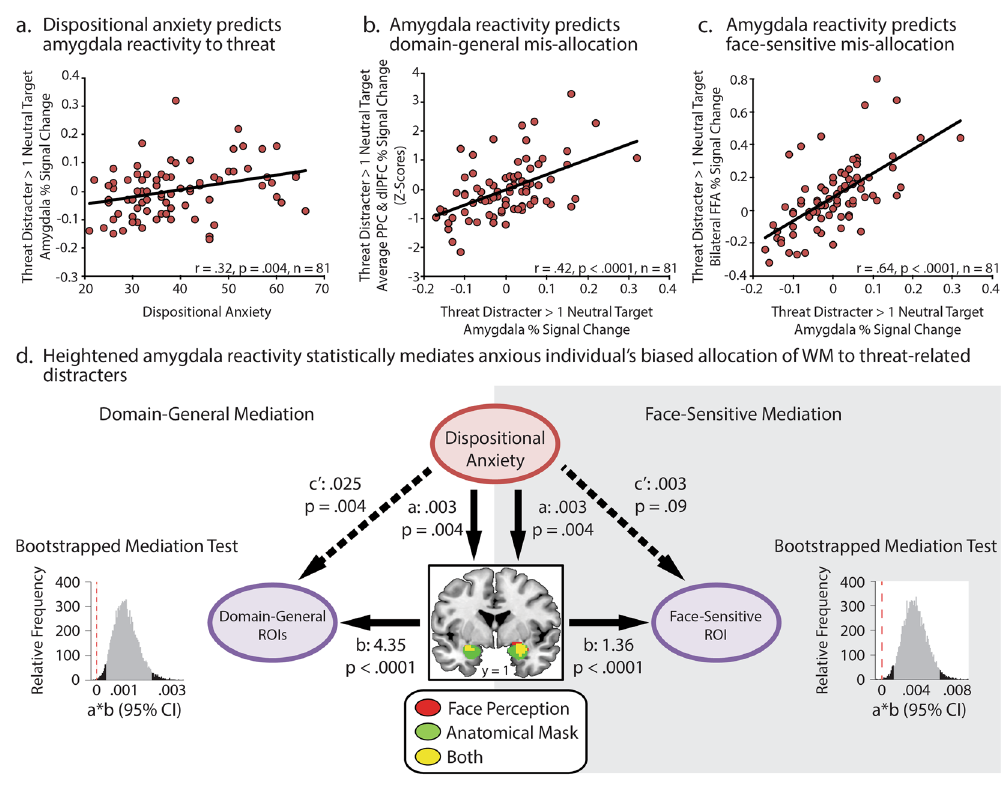
Figure 4. The amygdala promotes the mis-allocation of WM to threat-related distracters. ( a ) Individuals with a more anxious disposition show elevated amygdala reactivity to threat-related distracters. ( b , c ) In turn, elevated amygdala reactivity is associated with increased mis-allocation of domain-general (left PPC and left dlPFC) and face-sensitive (FFA) WM. ( d ) Path models and bootstrapping results are depicted for domain-general (left PPC and left dlPFC) and face-sensitive (FFA) ROIs. In both, relations between anxiety and WM mis-allocation were significantly reduced (path c ’) after controlling for threat-related amygdala activation, indicating significant mediation. Histograms show the bootstrapped 95% CI for the mediation test (product of paths a and b ; 10,000 samples). The 95% CIs are depicted in gray, with the dotted red line indicating